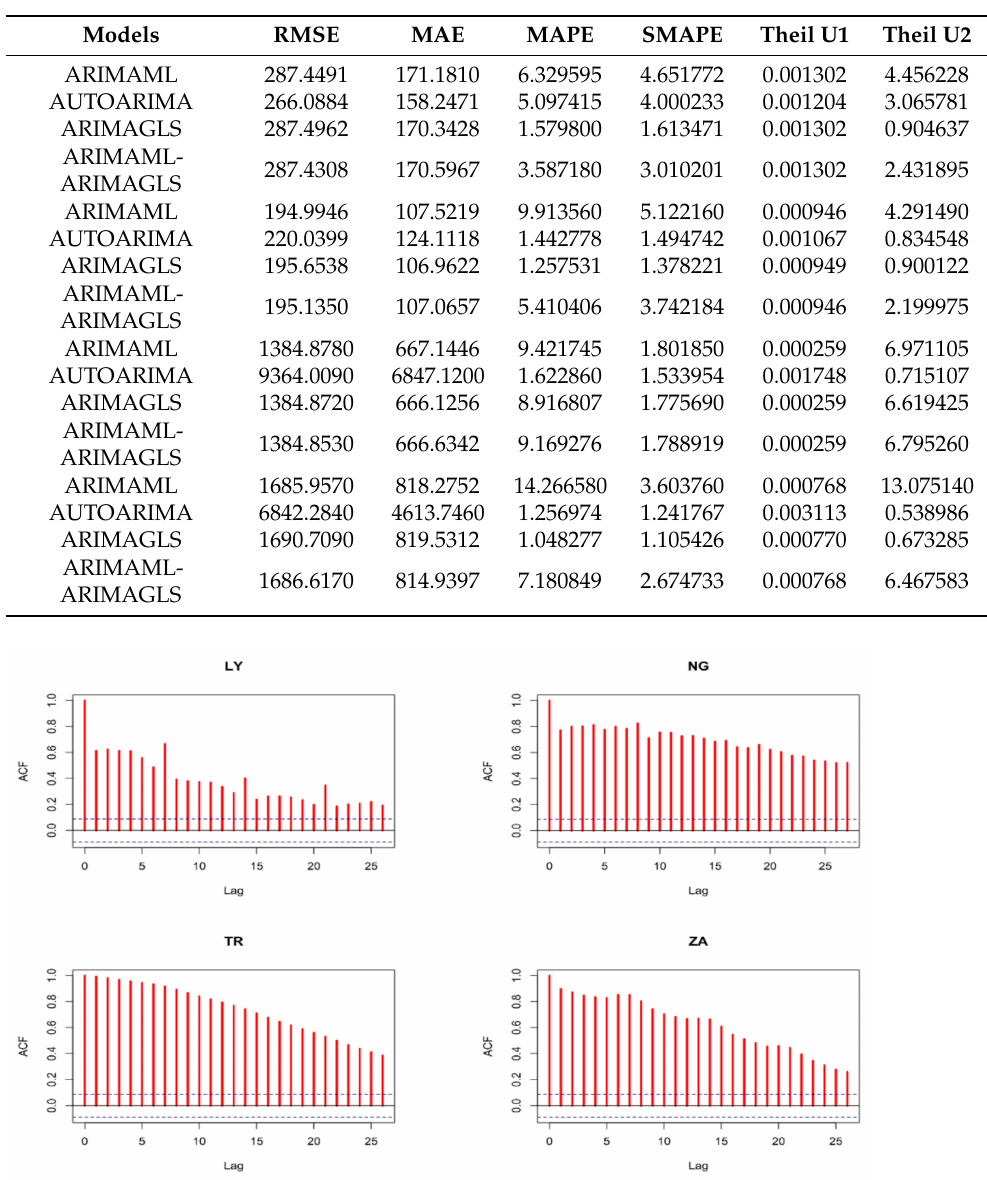
Table 3. Evaluation results for the training sample.